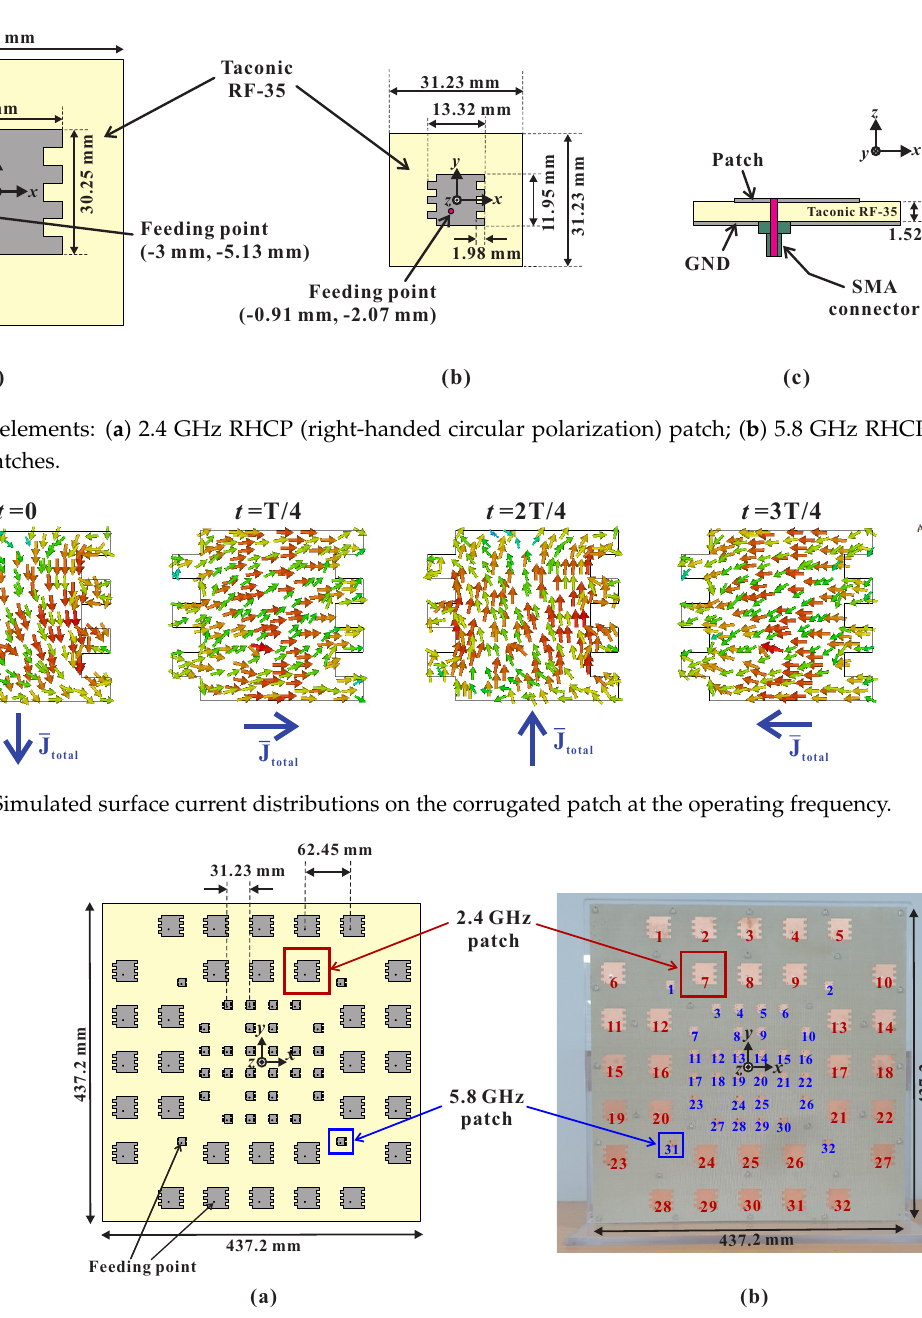
Figure 5. Optimized shared-aperture dual-band array: ( a ) configuration; ( b )